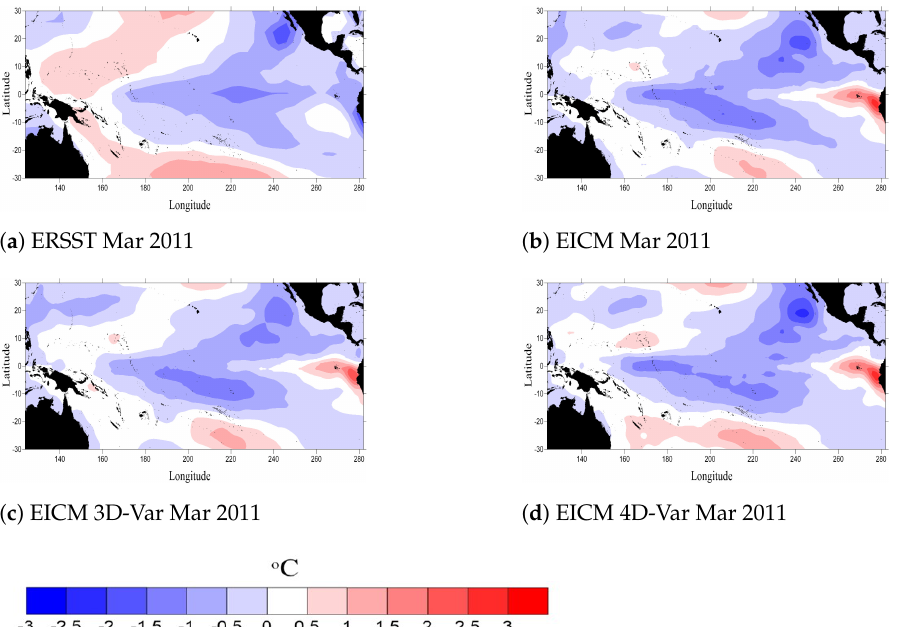
Figure 4. Pacific region SSTA values ( ◦ C) in March 2011 from ERSST measurements ( a ), and the SSTA prediction results at one-month lead time of EICM ( b ), EICM 3D-Var ( c ), and EICM 4D-Var ( d ). During the period of neutral state (June), it was found that the three simulations gave no significant difference in their forecasting values. However, it was found that the SSTA of the 4D-Var method was closer to the measurement data than 3D-Var and EICM at Niño region, respectively (Figure 5a–d).